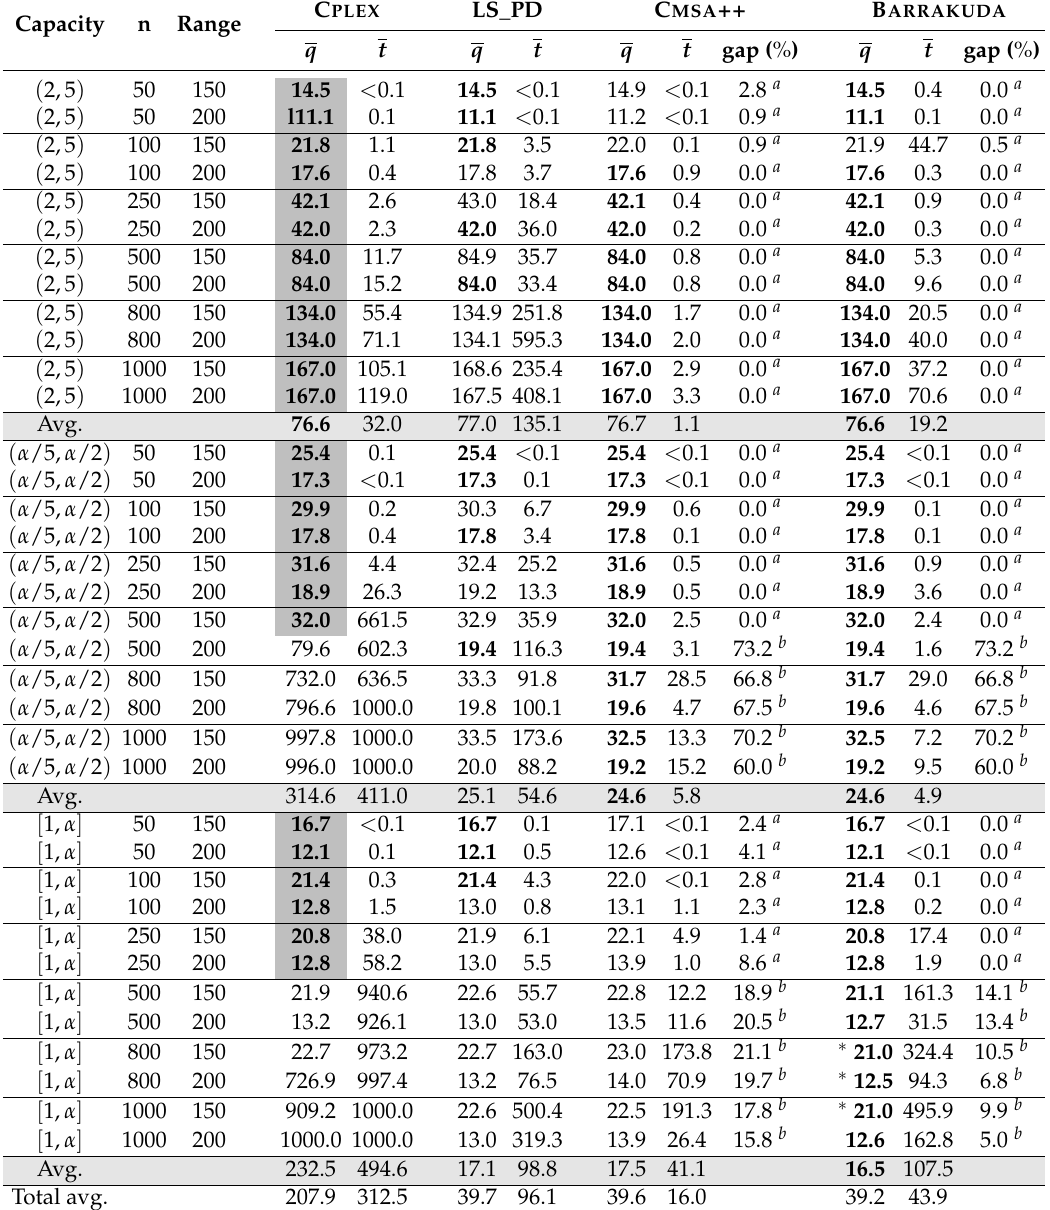
Table 8. Results for Unit Disk Graphs with variable